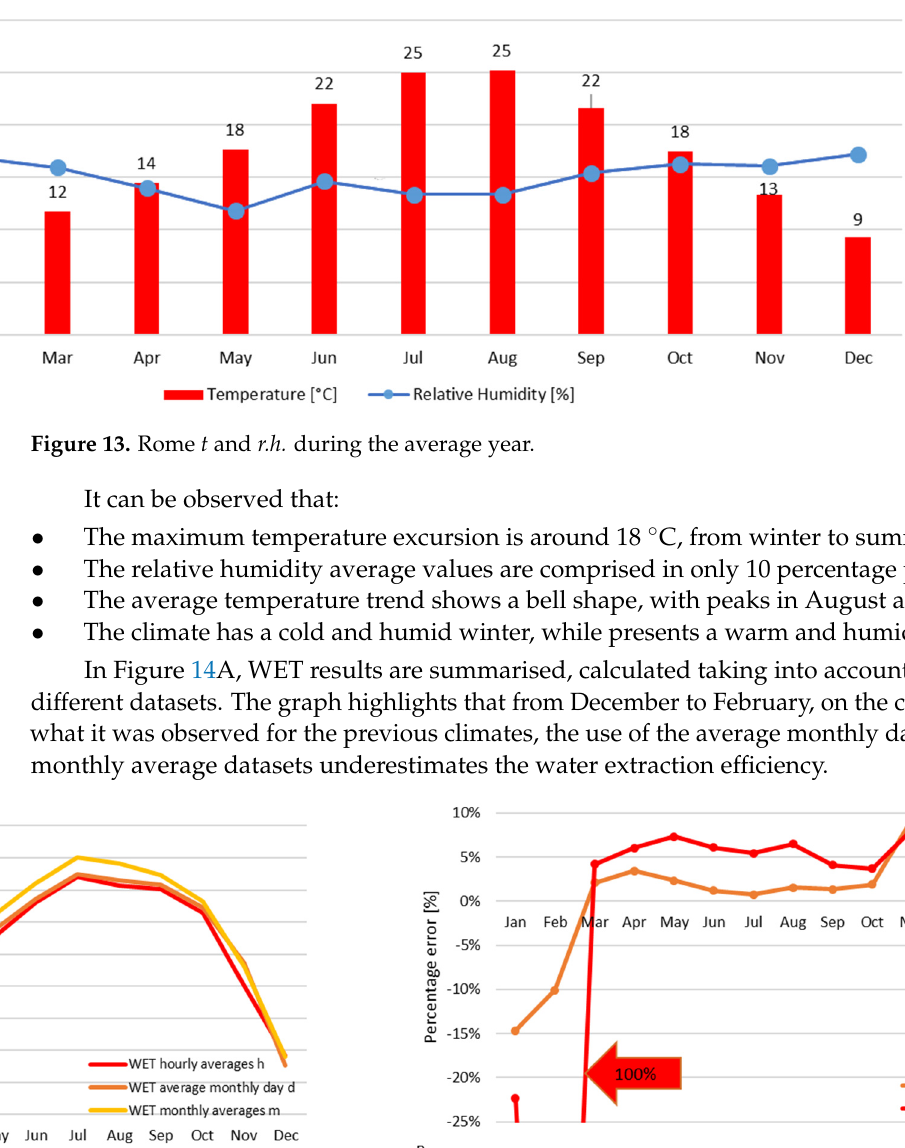
16 of 25 Figure 12. Dubai MHI values ( A ) and percentage error ( B ). In Figure 12A, it can be seen that the year presents an index value above 0.3, but there is a huge difference between the first five months of the year and the months from June to October. Even in this case, the MHI value trend has the same behaviour using different datasets. From Figure 12B, it can be understood that: The average month day data use (curve d-h) gives: • An error range of: 0.7–3.7% (avg 1.5%), the error is always under the 5% threshold; • The maximum error is in April (3.7%), not misleading. The average monthly data use (curve m-h) gives: • An error range of: 1.8–6% (avg 2.9%), the average error is under 5%. Overall, the per- centage error can be considered acceptable.